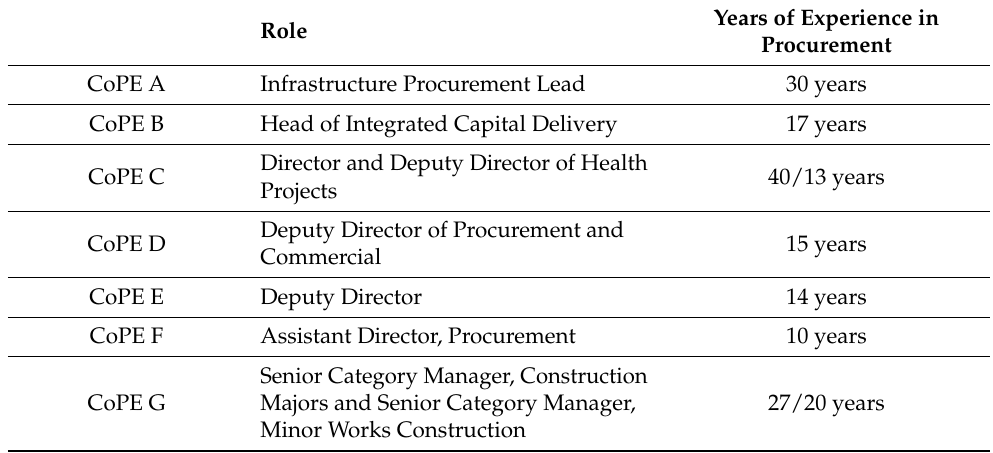
Table 4. Details of CoPE interviewees.